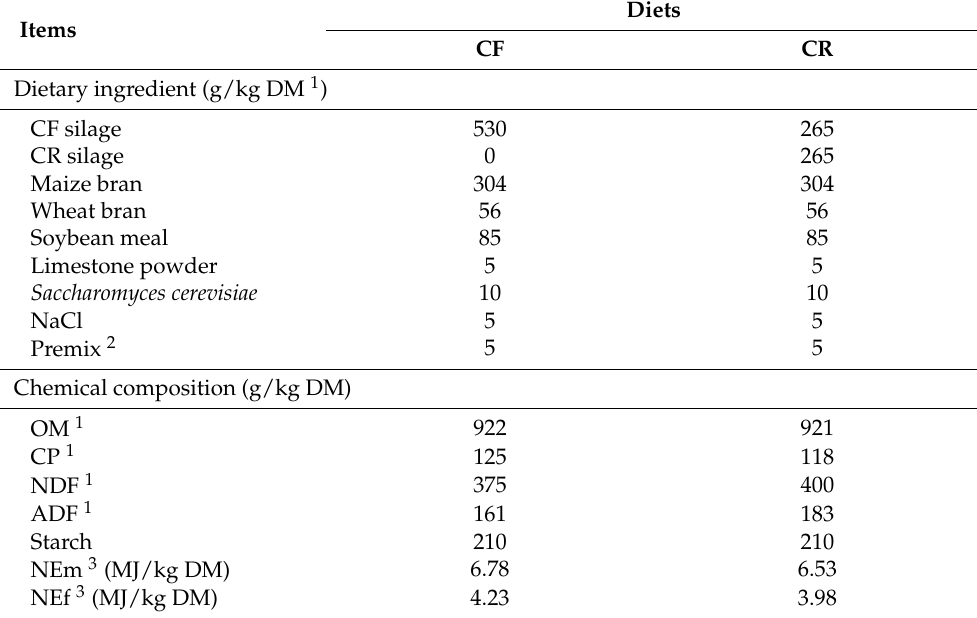
Table 2. Ingredients and chemical composition of corn stover after fresh-corn harvested (CF) and corn stover after ripe-corn harvested (CR) silage